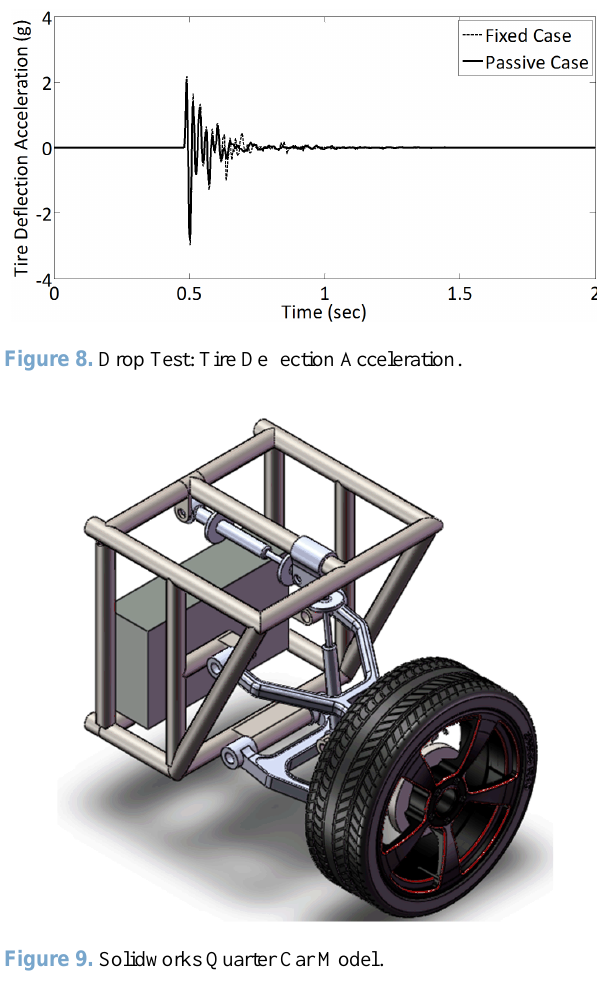
Table 2. Dynamic parameter